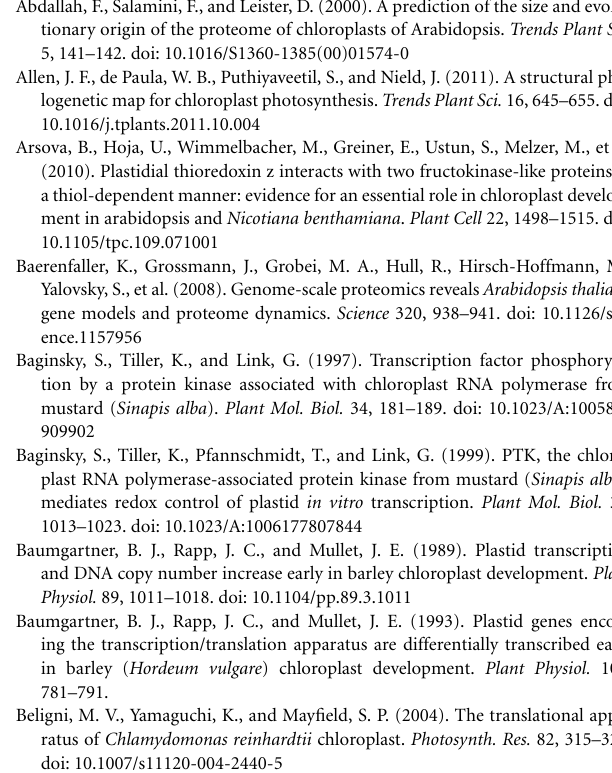
given right beside and below the gel,